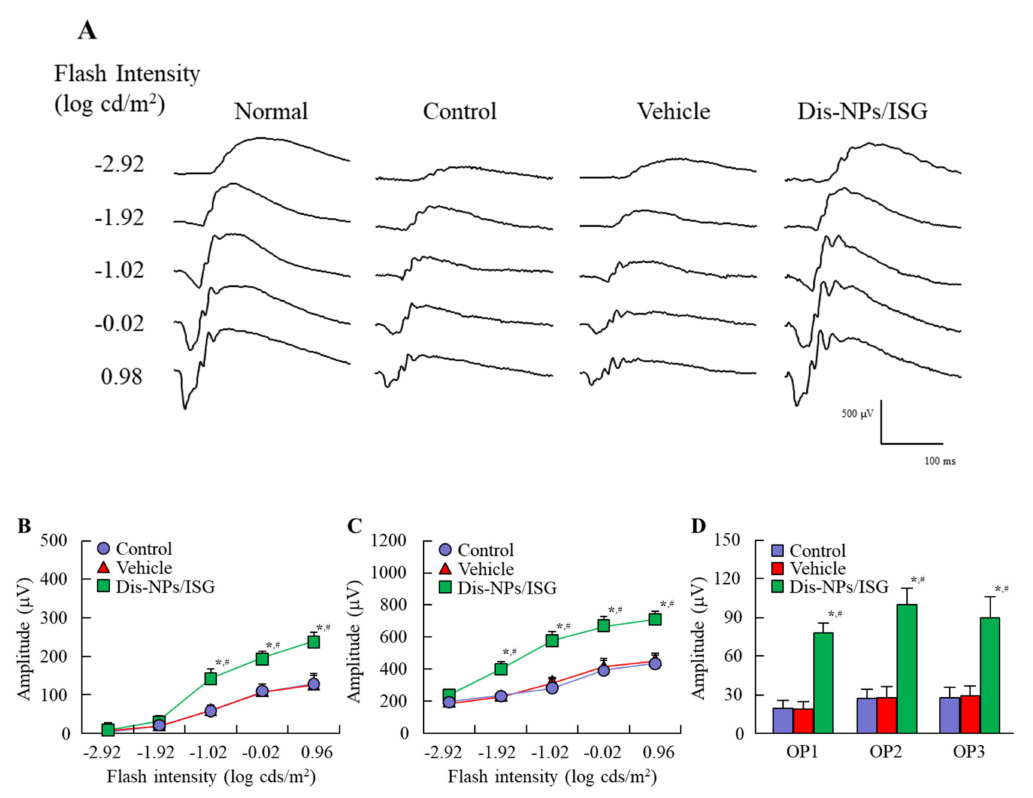
Figure 7. Typical traces of electroretinograms (ERGs) ( A ), a-wave amplitude ( B ), b-wave amplitude ( C ), and OP amplitude ( D ) in the right retina of 15-month-old OLETF rats repeatedly instilled with Dis-NPs / ISG. The Dis-NPs / ISG was repeatedly instilled into the right eye of OLETF rats for 1 month (twice a day, 9:00 a.m. and 7:00 p.m.). Normal, 4-month-old OLETF rat; Control, noninstilled OLETF rat; Vehicle, vehicle-instilled OLETF rat; Dis-NPs / ISG, Dis-NPs / ISG-instilled OLETF rat. n = 6–7. * p < 0.05 vs. control for each category. # p < 0.05 vs. vehicle for each category. The repetitive instillation of Dis-NPs / ISG recovered the decrease in retinal